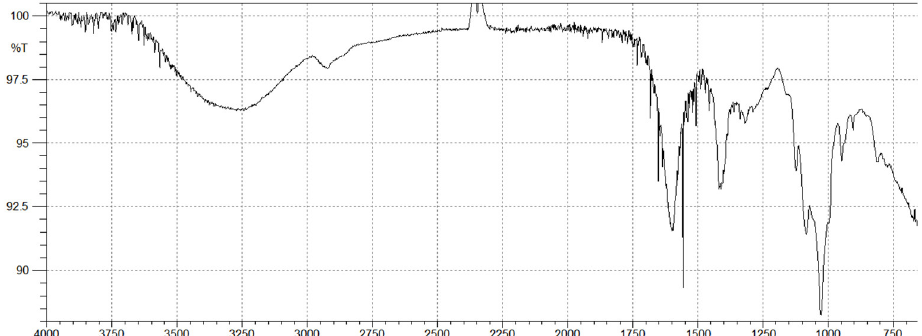
Figure 2. FTIR spectrum of alginate isolated from the Lebanese C. sinuosa.